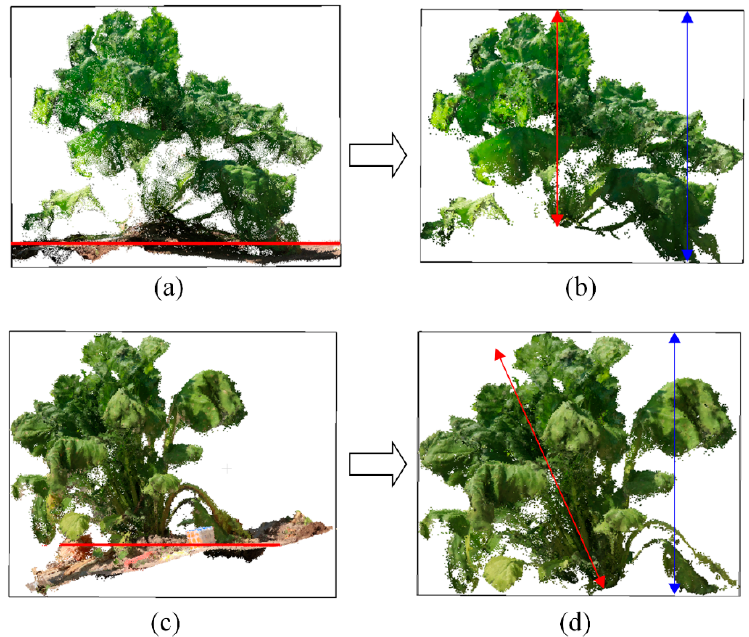
Figure 10. Two mismatched cases between measured and estimated plant height. ( a ) Plant A after coordinate correction; ( b ) Plant A after filtering; ( c ) Plant B after coordinate correction; ( d ) Plant B after filtering. Horizontal red lines were ground plane obtained by RANSAC algorithm. Red and blue arrowed lines were measured and estimated height.